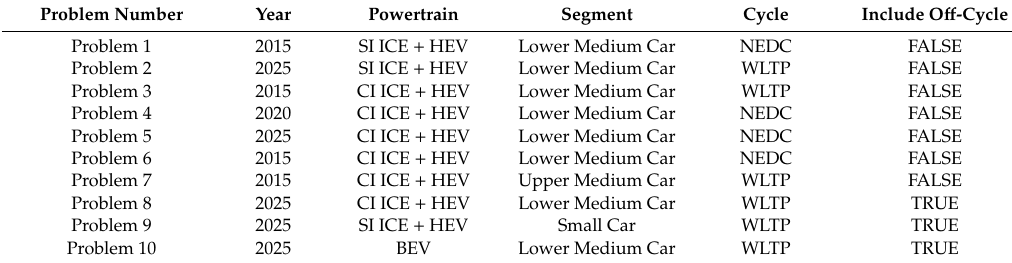
Table 1. Reference table of the benchmark problems, with typical cost scenario and total cost type. See Nomenclature for abbreviations or Section 5 for extended descriptions of the parameter